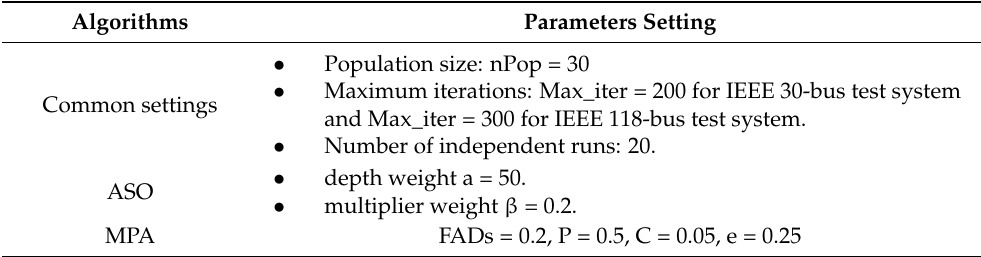
Table 3. The parameter settings of different optimization